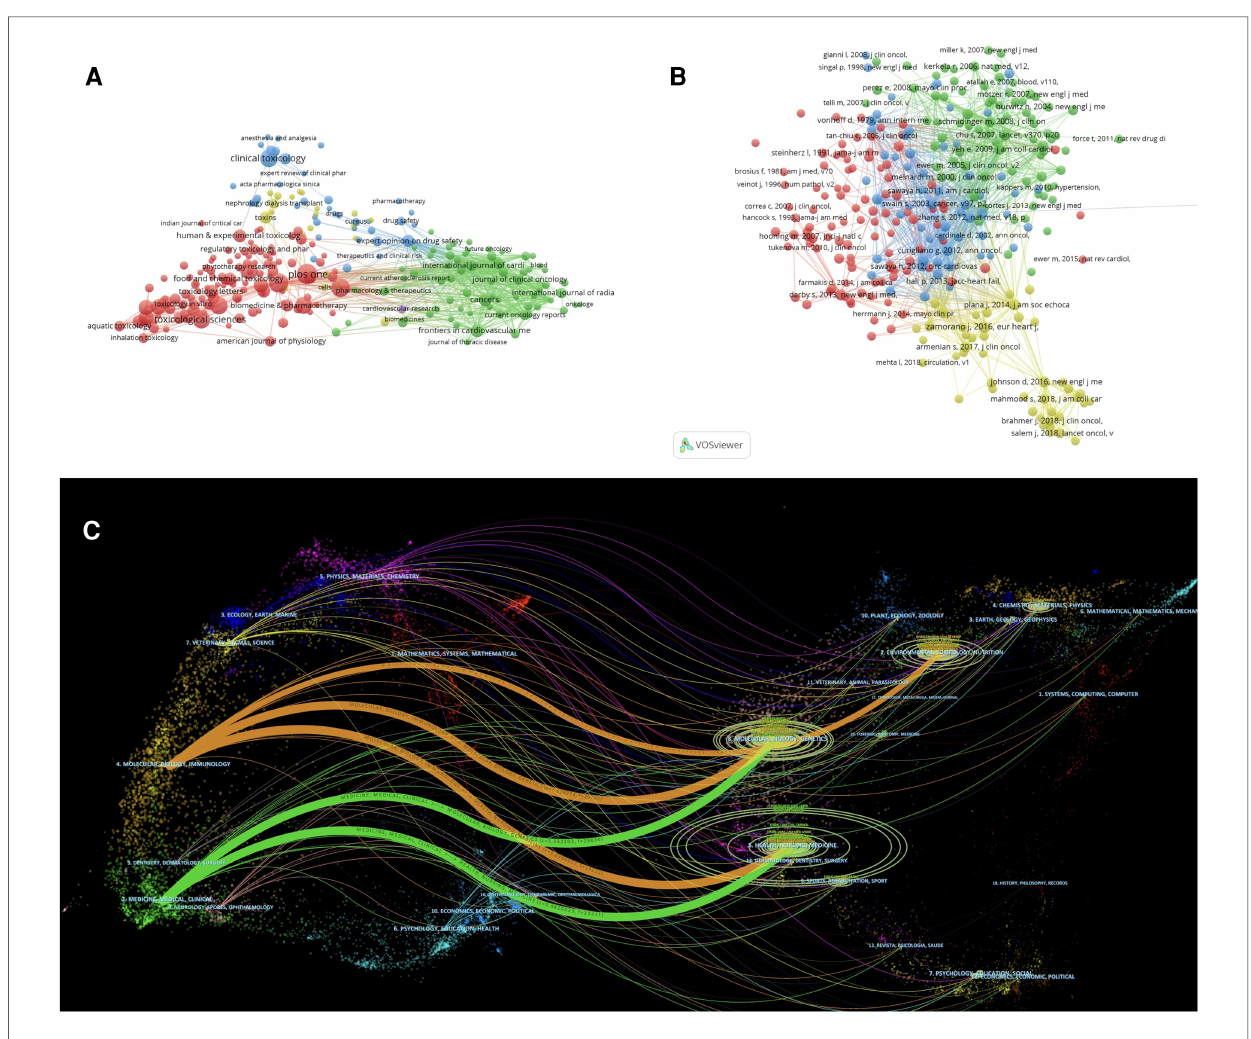
FIGURE 5 ( A) network map of journals analysis based on VOS viewer. ( B ) Network map of co-cited journals analysis based on VOS viewer. ( C ) A dual-map overlay of the journals on cardiotoxicity research generated by using CiteSpace software. In the dual-map, the citing journals appear on the left side of the map, and the cited journals are on the right. The wider lines that begin from the citing journals and end at the cited journals represent the main citing pathways calculated from the so-called z-score of the citation links.